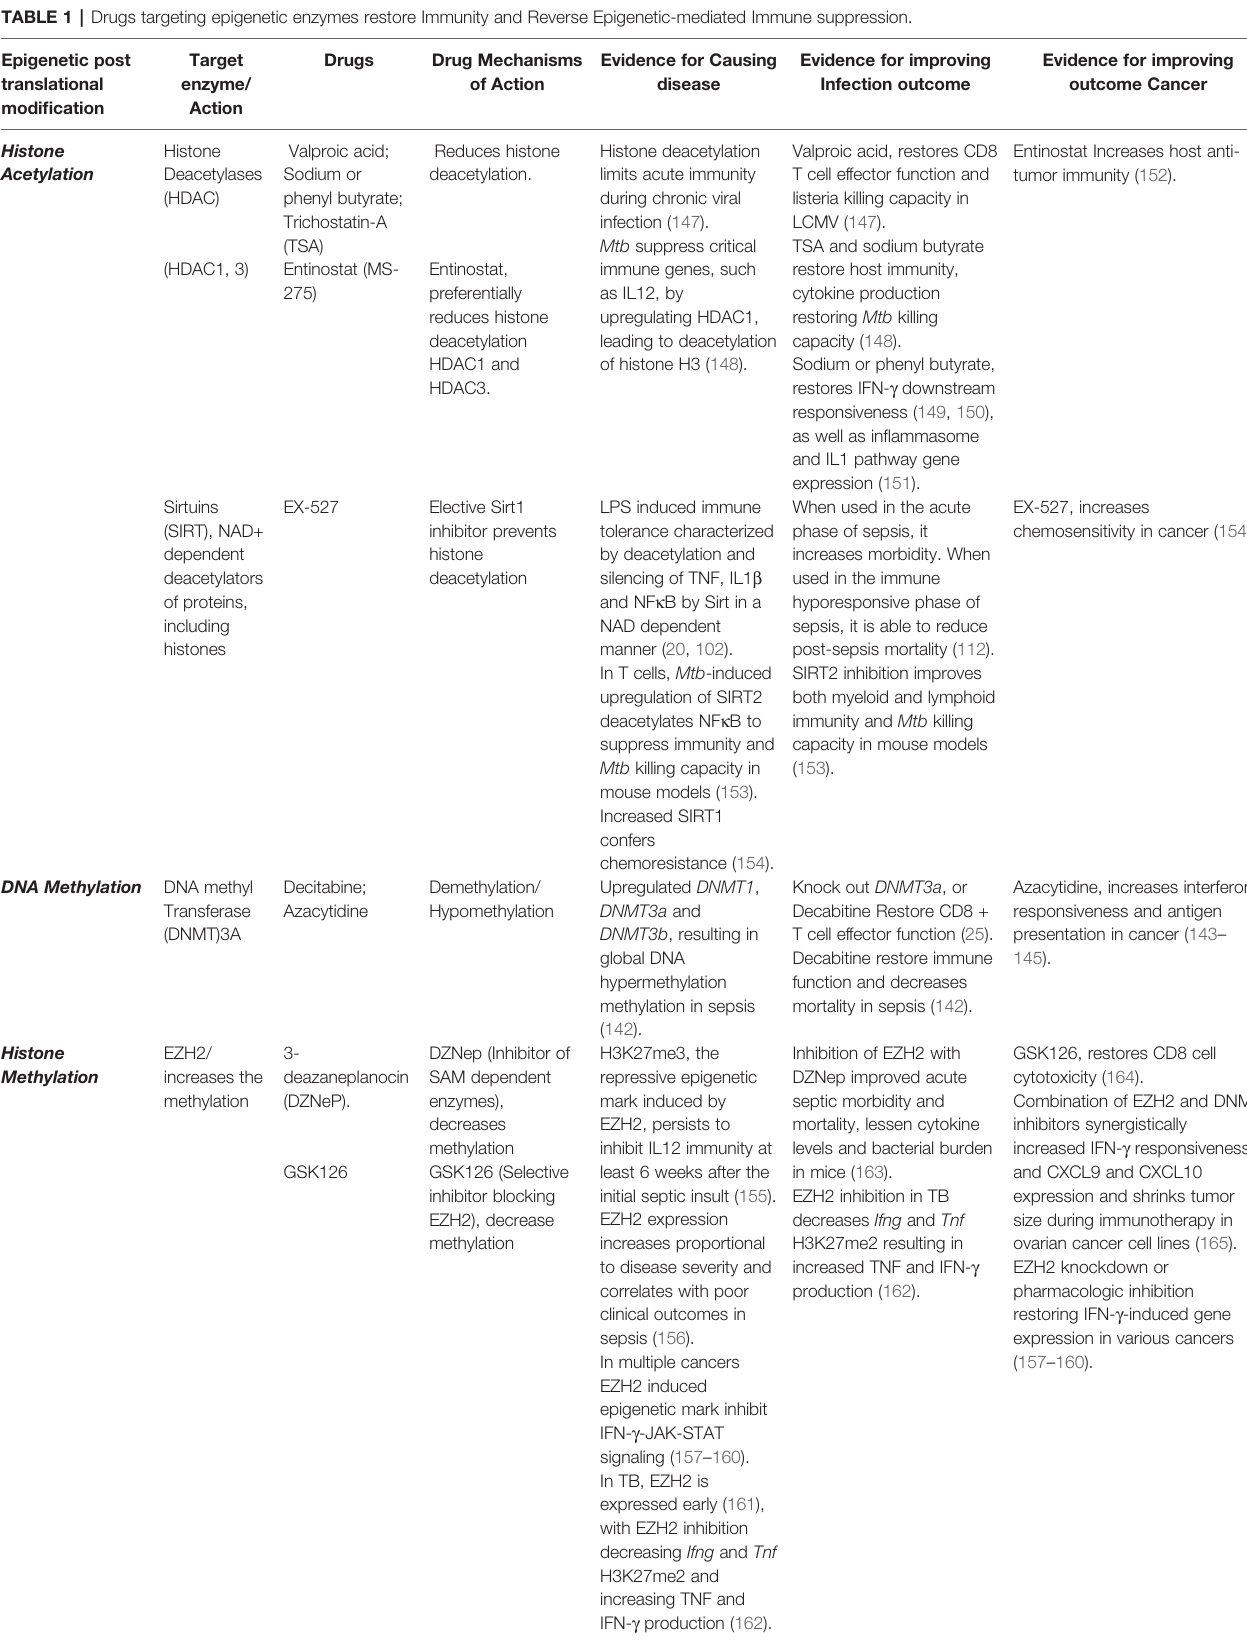
TABLE 1 | Drugs targeting epigenetic enzymes restore Immunity and Reverse Epigenetic-mediated Immune